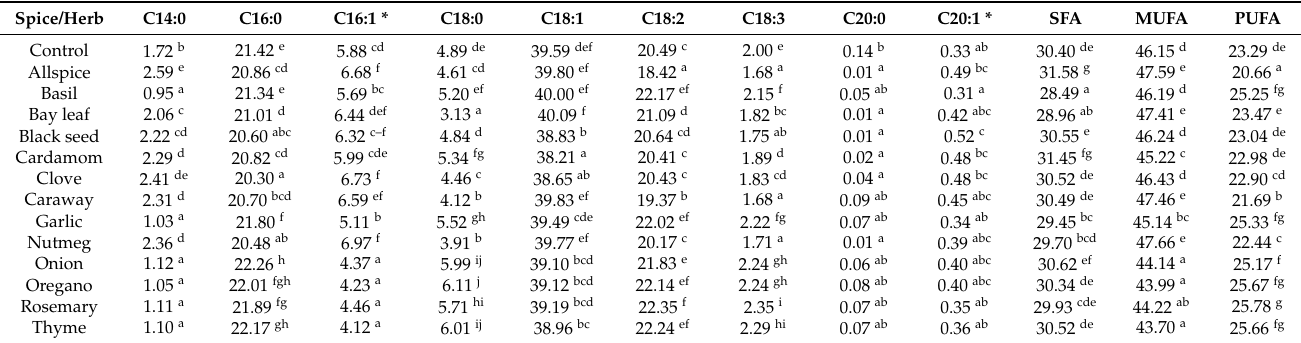
Table 1. Fatty acid composition (%) of raw chicken legs during 13 days of storage at 4 ◦